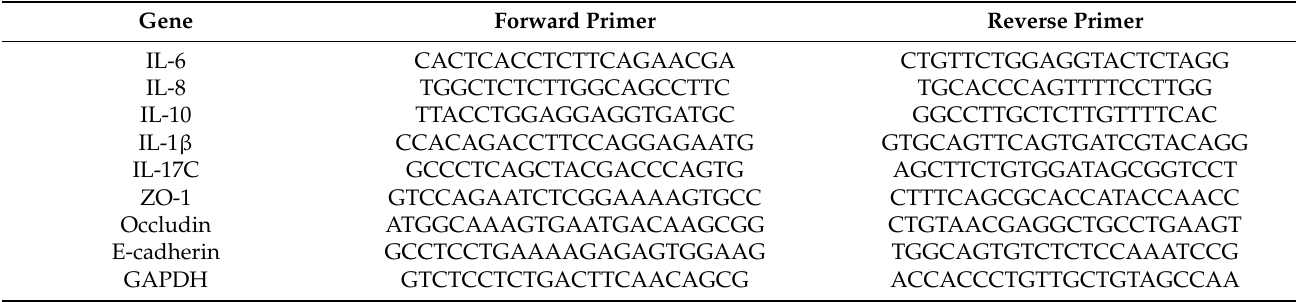
Table 1. Human primer sequence for